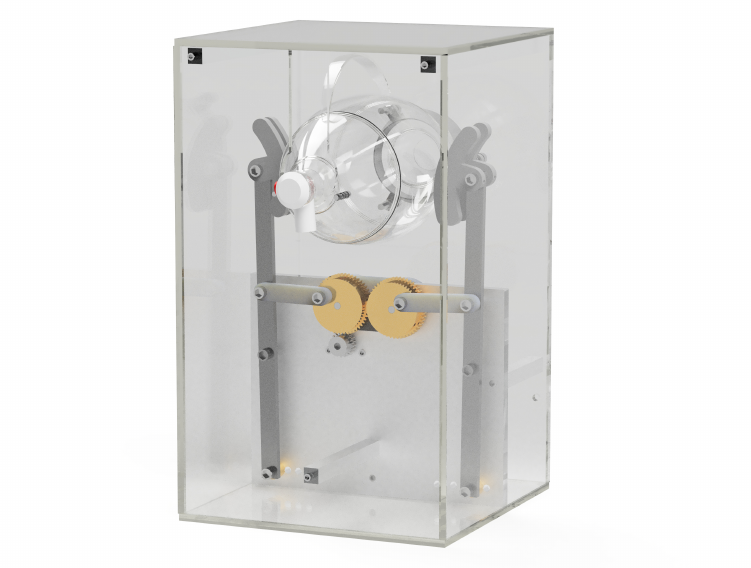
Figure 1. Three-dimensional render of the prototype of the contingence life-support air pressure emergency respirator